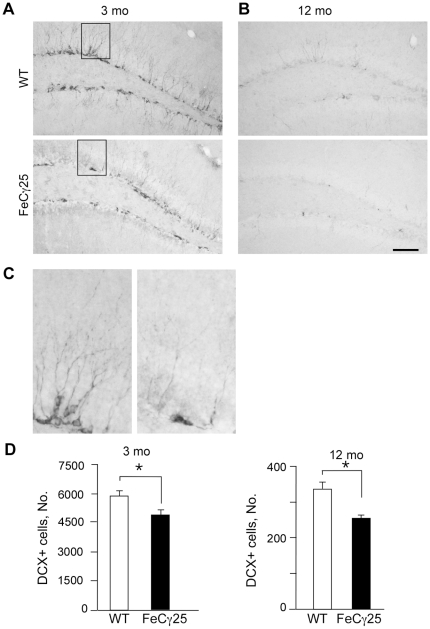
FeCγ25 mice show a decreased number of immature neurons in the SGZ of dentate gyrus (DG).
A–B, Coronal sections from 3 mo (A) and 12 mo (B) brains of wild-type and FeCγ25 mice were immunostained for the immature neuronal marker doublecortin (DCX). There is an abundance of immature neurons in the SGZ of the granule cell layer in both the supra- and infra-pyramidal blades of the DG. Compared to the wild-type (top) there is a significant decrease in the number of DCX+ cells in the SGZ of FeCγ25 mice (bottom). C, Magnification of the boxed region in (A) show the diminished number of DCX+ cells in FeCγ25 mice at 3 mo of age with a concomitant decline in dendritic number. (D) Quantitative analysis of the total number of DCX+ cells throughout the entire rostro-caudal extent of the hippocampus in 3-month-old (left) and 12-month-old (right) animals reveal a statistically significant decrease in the number of DCX+ cells in the SGZ of FeCγ25 mice compared to wild-type mice. Scale bar  = 100 µm. n = 4 for all.